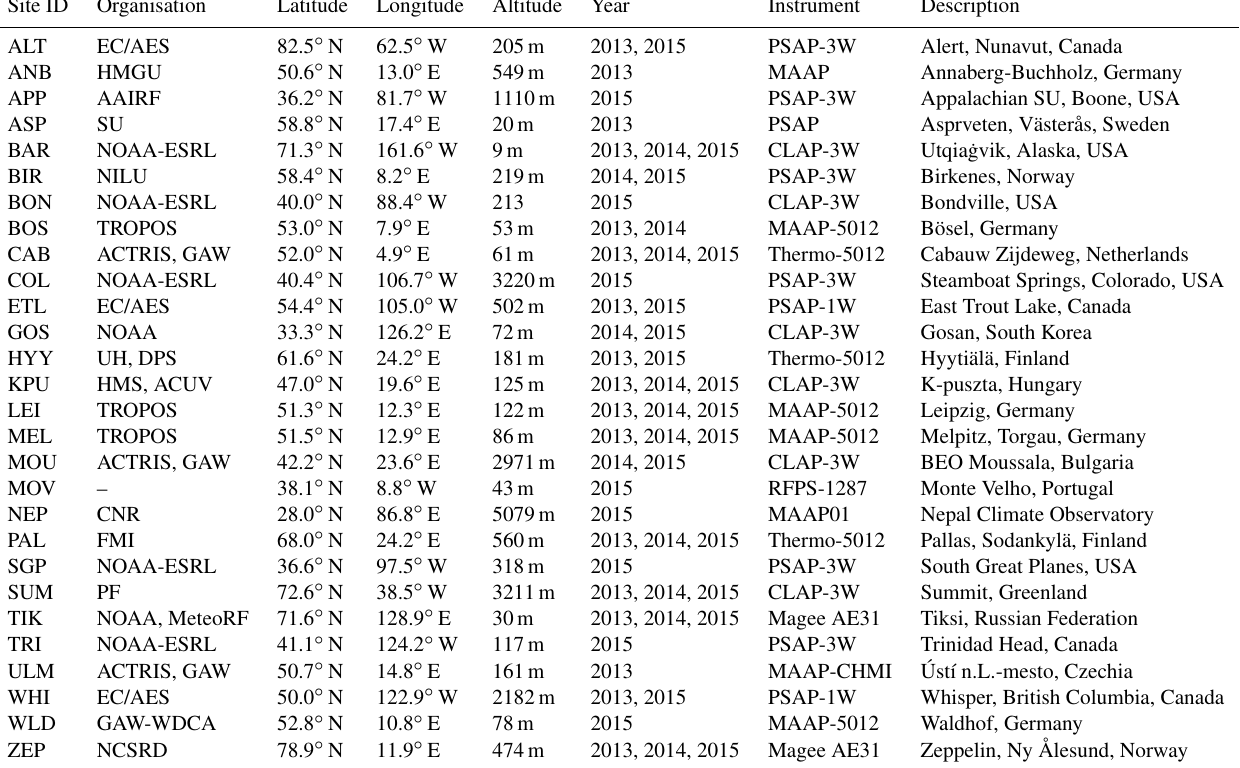
Table 1. Observation sites used for the inversions (the altitude indicates the sampling height in metres above sea level). Site ID